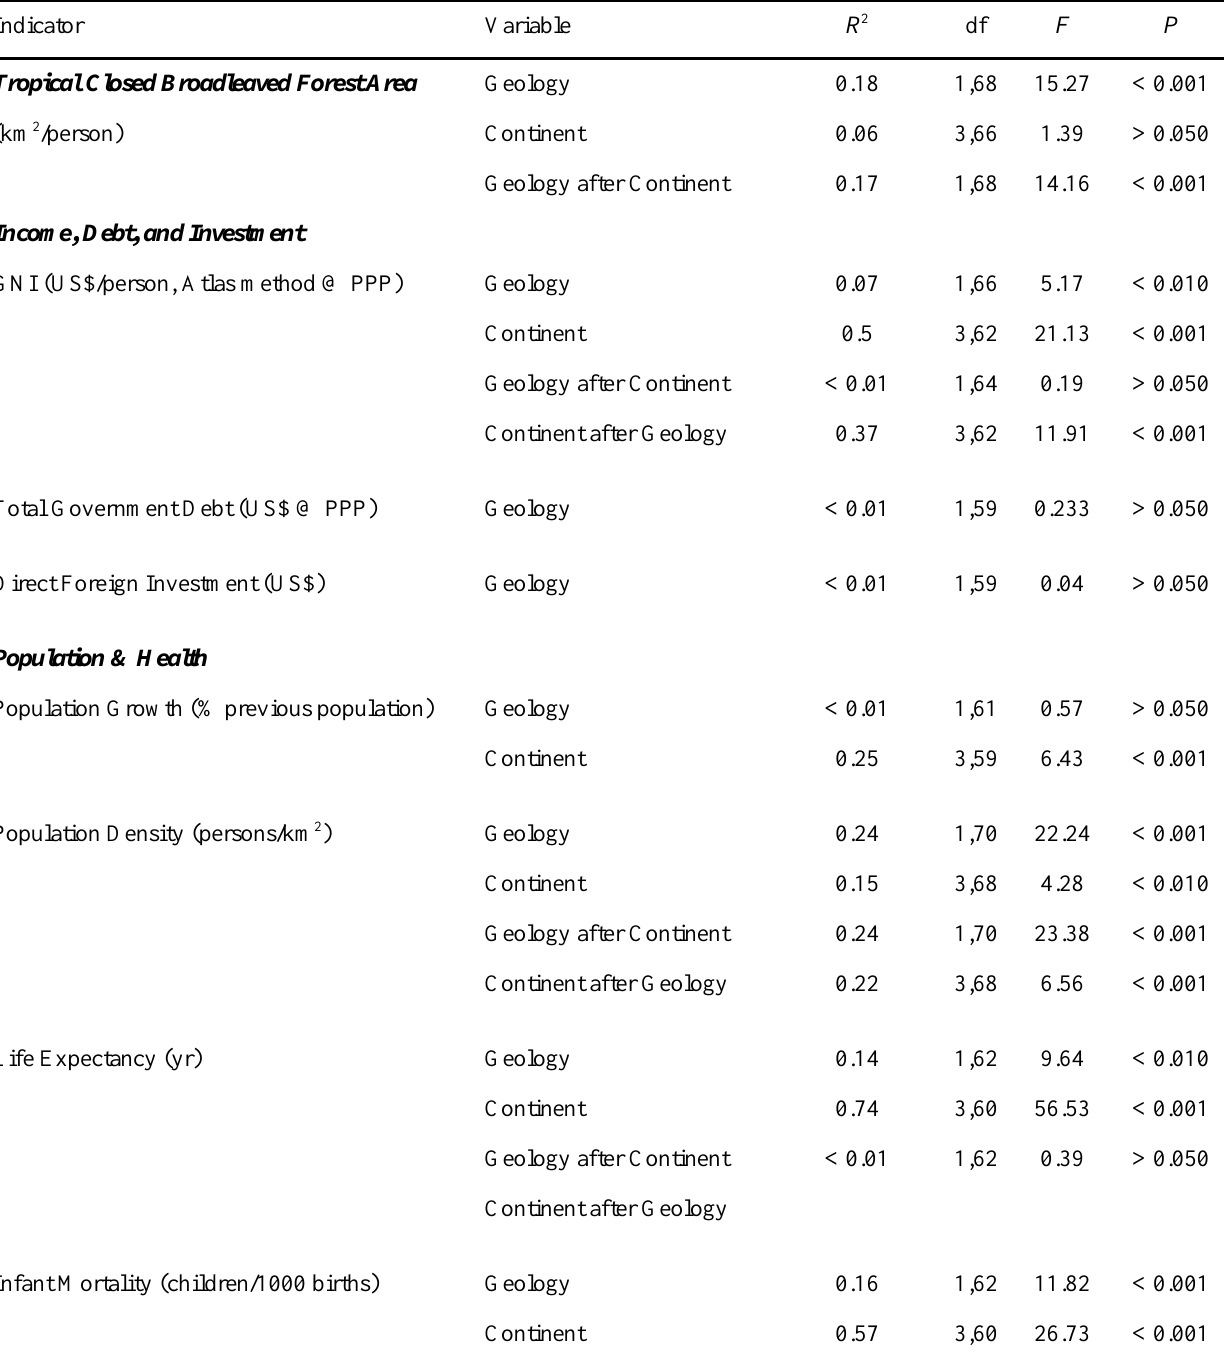
Table 3. Selection of transformed socioeconomic indicators run through a series of generalized linear models to assess the role of geology, i.e., precambrian vs. phanerozoic, and geographic region, i.e., Neotropics, Africa, Asia, and Oceania, in explaining pantropical variation.